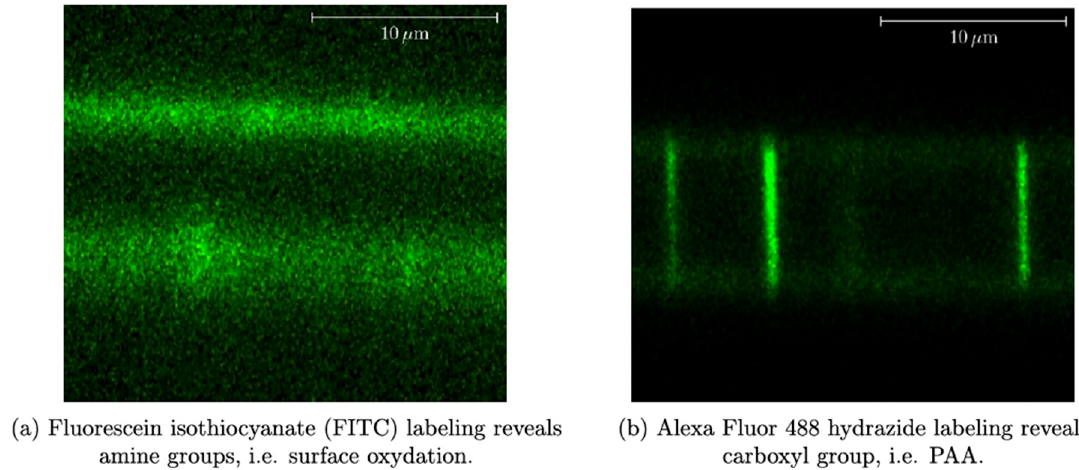
Figure 11. Confocal Laser Scanning Microscopy (CLSM) images of labeled PAA-g-PVDF membranes from ref [215].